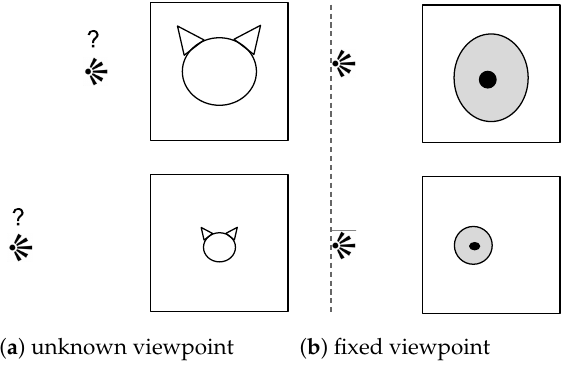
Figure 1. Illustration of ( a ) an unknown and varying viewpoint typical in natural images that requires scale-invariant analysis and ( b ) a controlled viewpoint in which a difference in size carries crucial information that is discarded by a scale invariant